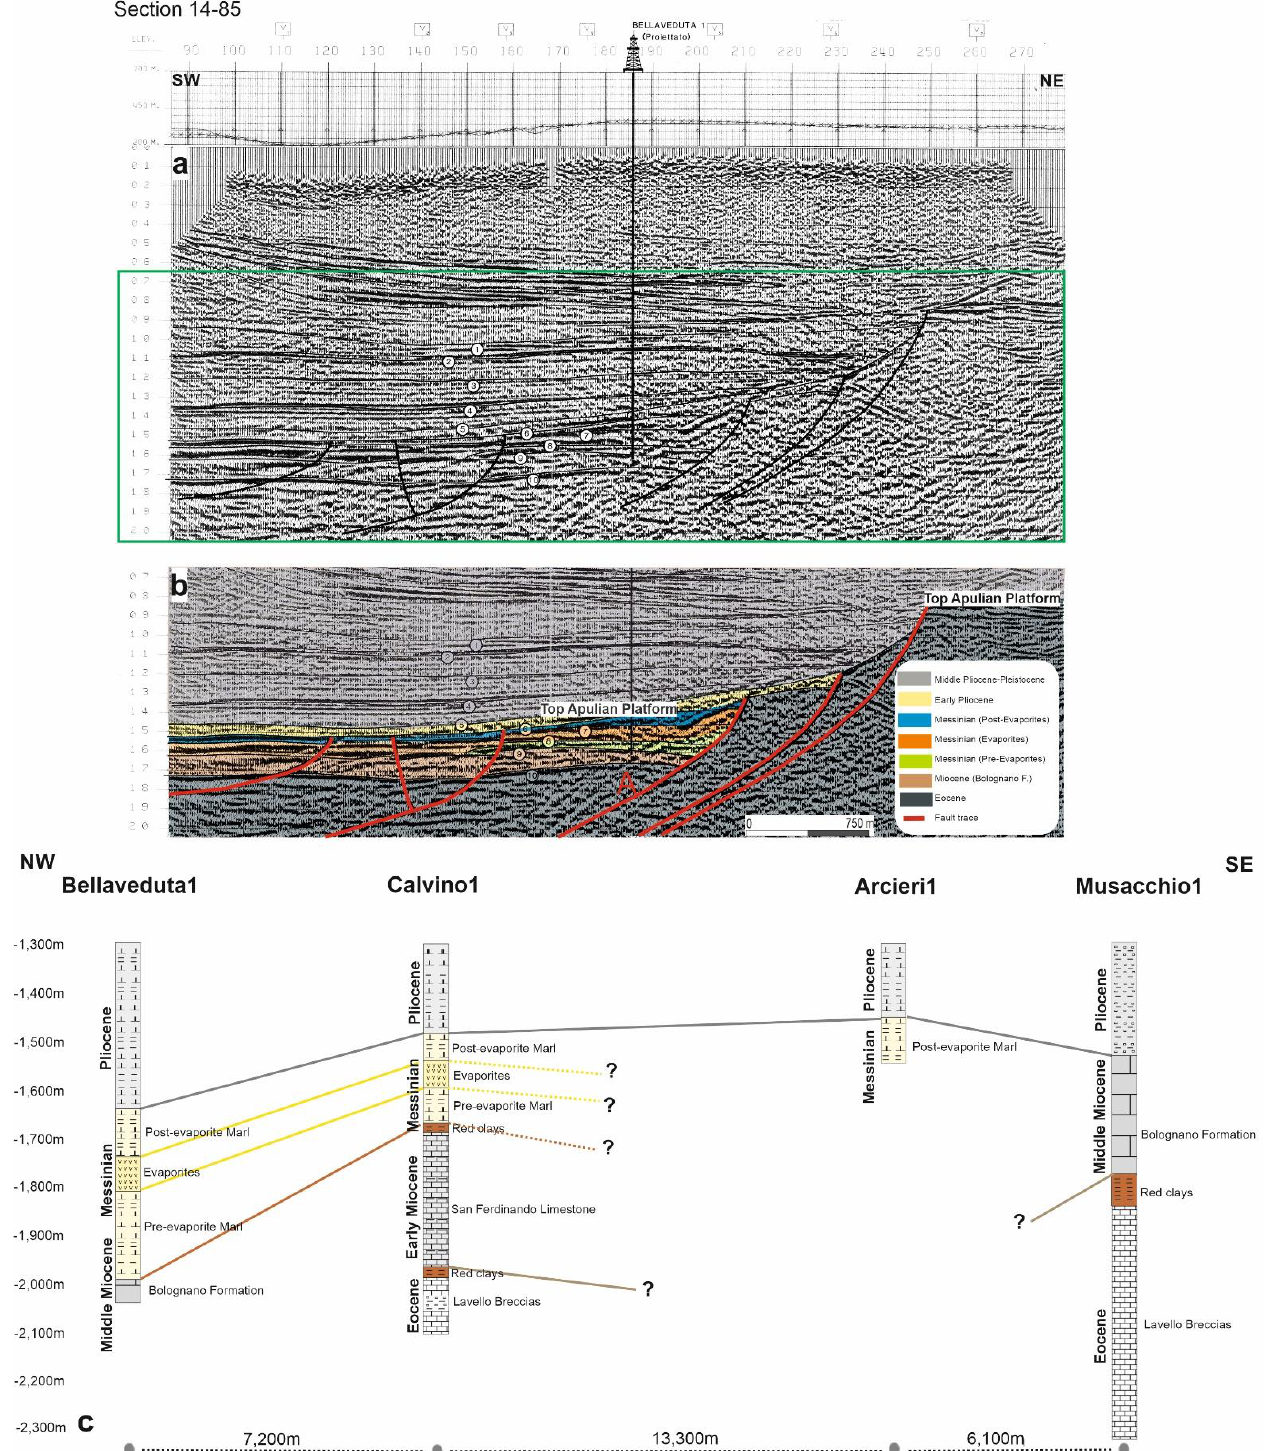
Figure 6. ( a ) Uninterpreted and ( b ) interpreted NE–SW oriented seismic reflection profiles 14-85, showing the listric geometry of the NW–SE trending faults, with syn-sedimentary activity during deposition of the Messinian deposits (1-conglomerates, 2-top sands of Bellaveduta well, 3-bottom sands of Bellaveduta well, 4-calcarenitic level, 5-top Early Pliocene, 6-top carbonates, 7-gypsum, 8-top lacustrine, 9-top limestone and dolomite, 10-top Cretaceous). ( c ) Schematic stratigraphic profile, parallel to the fault scarp, derived from the correlation of Bellaveduta1, Calvino1, Arcieri1, and Musacchio1 exploration wells. See Figure 3a for the location of the wells.